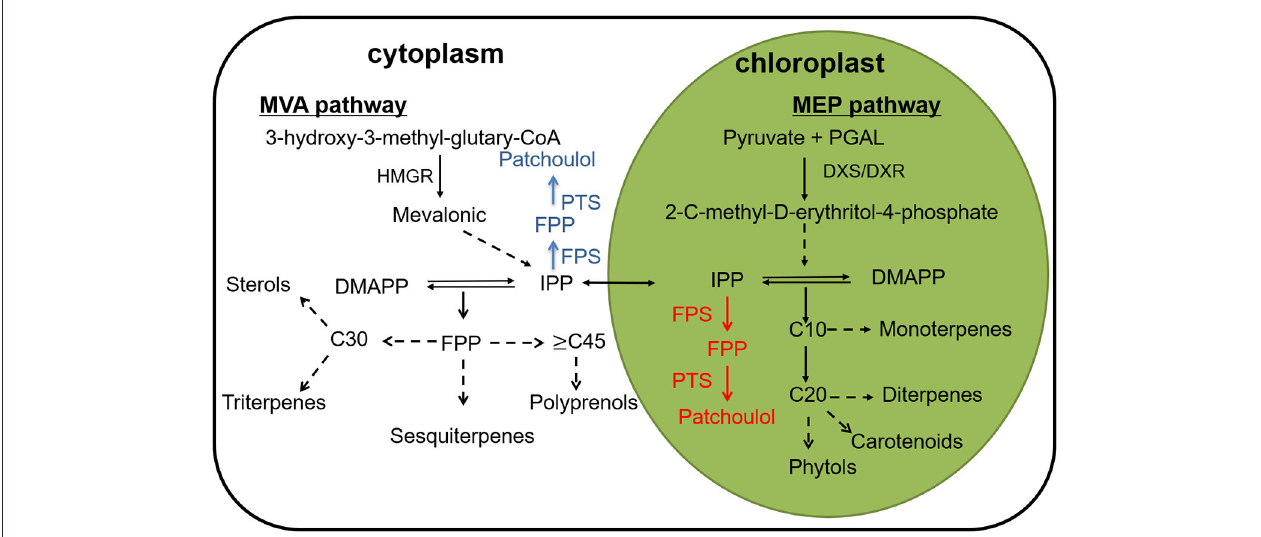
FIGURE 1 | A depiction of the terpene biosynthesis, along with a conceptualization for patchoulol biosynthesis to the cytoplasm (blue) and to the chloroplast (red) compartments. HMGR, 3-hydroxy-3- methylglutaryl coenzyme A reductase; DXS, 1-deoxy-D-xylulose-5-phosphate synthase; DXR, 1-deoxy-D-xylulose5-phosphate reductase; FPS, farnesyl diphosphate synthase; FPP, farnesyl pyrophosphate; PTS, patchoulol synthase.